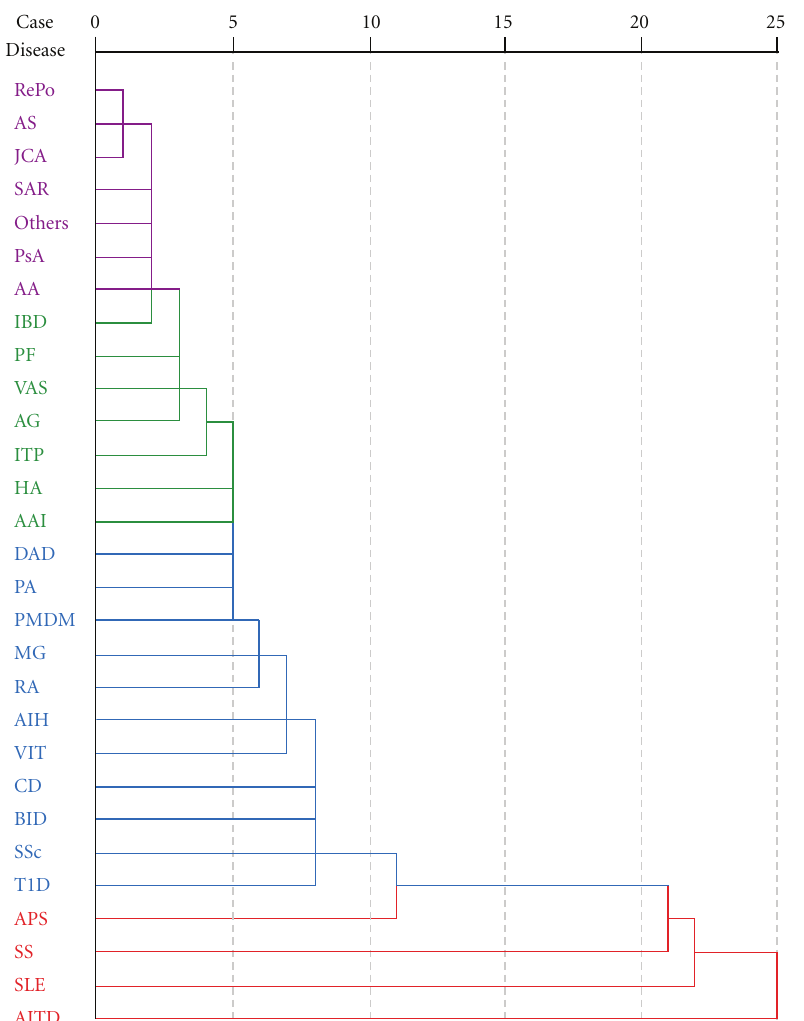
Figure 2: Cluster analysis dendogram. Each node represets a stage from the clustering process. There were four clusters. The most hierarchical was composed of four ADs. AITD: autoimmune thyroid disease (including thyroiditis, Hashimoto disease, Graves disease); SLE: systemic lupus erythematosus; SS: Sj ¨ ogren’s syndrome; APS: antiphospholipid syndrome; T1D: type 1 diabetes mellitus; SSc: scleroderma (including localized, systemic, di ff use, limited); BID: billiary inflammatory disease (including primary biliary cirrhosis, primary sclerosing cholangitis); CD: celiac disease; VIT: vitiligo; AIH: autoimmune hepatitis; RA: rheumatoid arthritis; MG: myasthenia gravis; PMDM: polymyositis/dermatomyositis; PA: pernicious anemia; DAD: demyelinating autoimmune diseases (including multiple sclerosis, transverse myelitis, optic neuromyelitis); AAI: autoimmune adrenal insu ffi ciency (Addison disease); HA: autoimmune anemia; ITP: idiopathic thrombocytopenic purpura; AG: autoimmune gastritis; VAS: vasculitis (including Churg-Strauss syndrome, giant cell arteritis, microscopic polyangiitis, cryoglobulinemia, polyarteritis nodosa, Wegener granulomatosis); PF: pemphigus (including vulgaris, bulloso, foliaceous); IBD: inflammatory bowel disease (including ulcerative colitis, Crohn’s disease); AA: alopecia areata; PsA: psoriasis (including psoriatic arthritis); SAR: sarcoidosis; JCA: juvenile chronic arthritis; AS: ankylosing spondylitis; RePo: relapsing polychondritis.